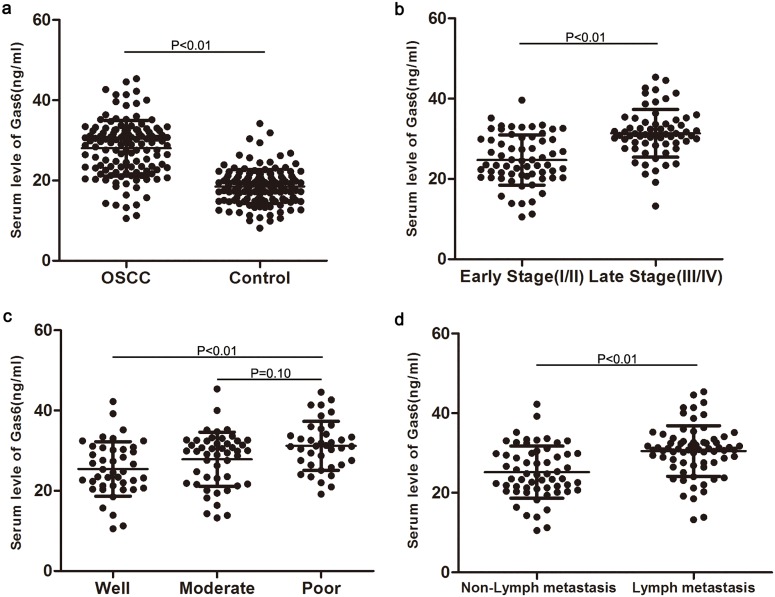
Serum Gas6 level for 128 OSCC patients and 145 normal controls (a); serum Gas6 level in OSCC patients with differing TNM stages (b); serum Gas6 level in OSCC patients with differing pathological differentiation (c); serum Gas6 level in OSCC patients with and without lymph nodal metastases (d).